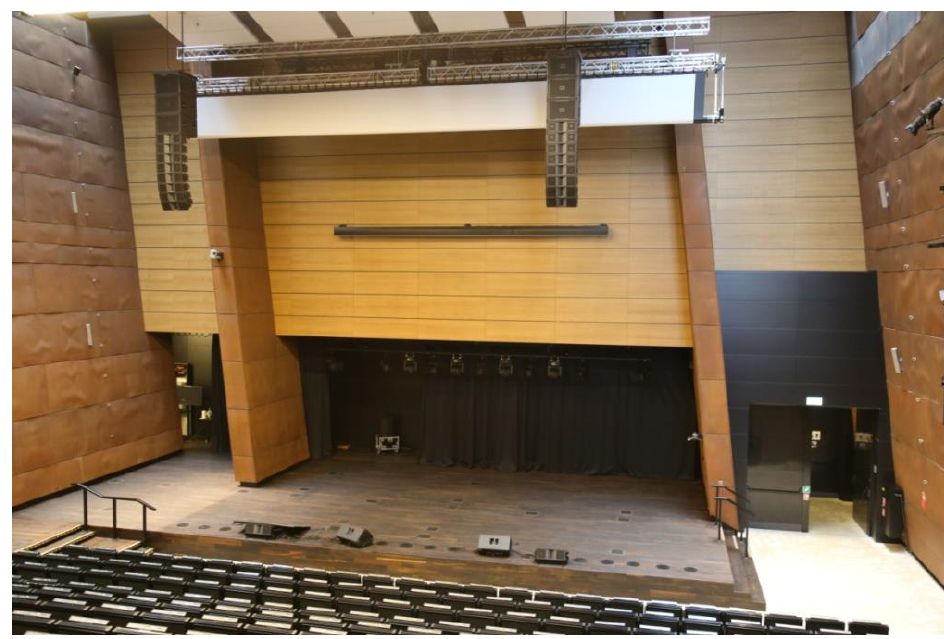
Figure 11. The multi-purpose hall, view from the audience on the stage (photo by Wojciech Targowski). Dimensions of the multi-purpose hall—length × width × height—30.5 × 20.7 × 17.6 m; stage—length × width—15.3 × 9.1 m; floor area—483 m 2 ; cubature—5700 m 3 ; number of seats—433, surface of the corten plates—approx. 940 m 2 ; reverberation time at the frequency 1000 Hz—1.3 s (Figure 12).